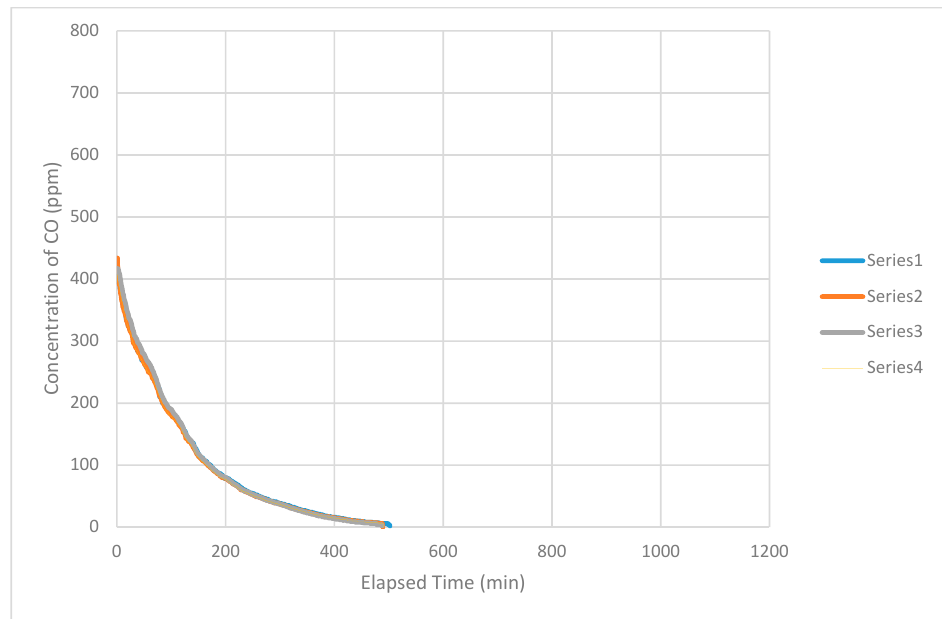
Figure 4. Decrease in concentration of CO in the airspace of the structure with time (2 February 2015). Generally, the concentration of CO in the airspace of the structure decreased along a smooth band where relative position of the readings remained the same. Series 1 to Series 4 reflected the position of the instruments on the stand at 152 cm (60 in), 114 cm (45 in), 76 cm (30 in), and 38 cm (15 in) above the bottom, respectively. The curves superimpose onto each other.